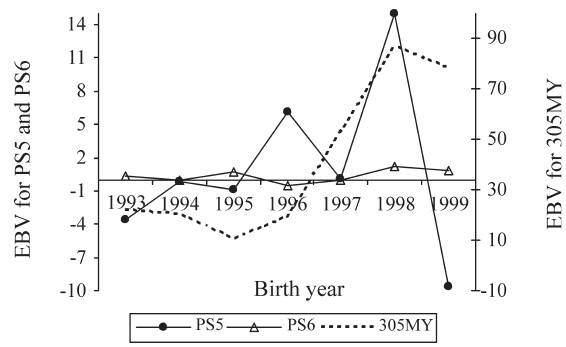
Figure 9 - Average estimated breeding values for 305-day milk yield and persistency of lactation of sires according to the birth year of cows.